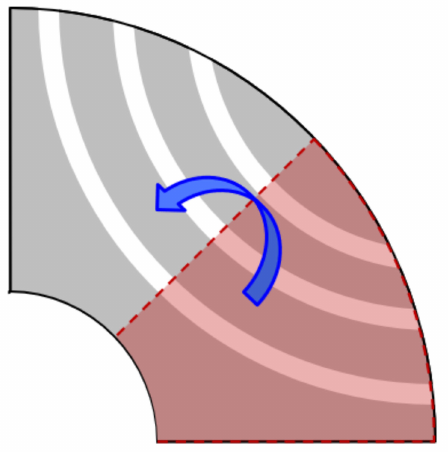
Figure 2. 90-degree periodic model with symmetry properties.